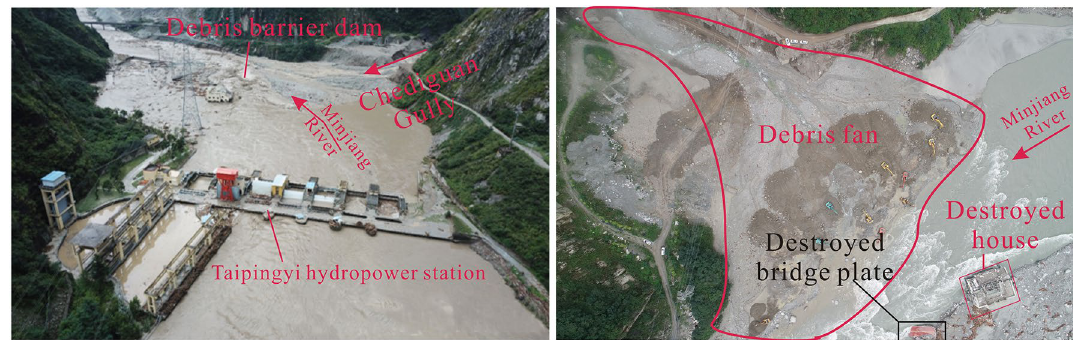
Figure 12. Debris fan and barrier lake formed in the “8.20” debris flow